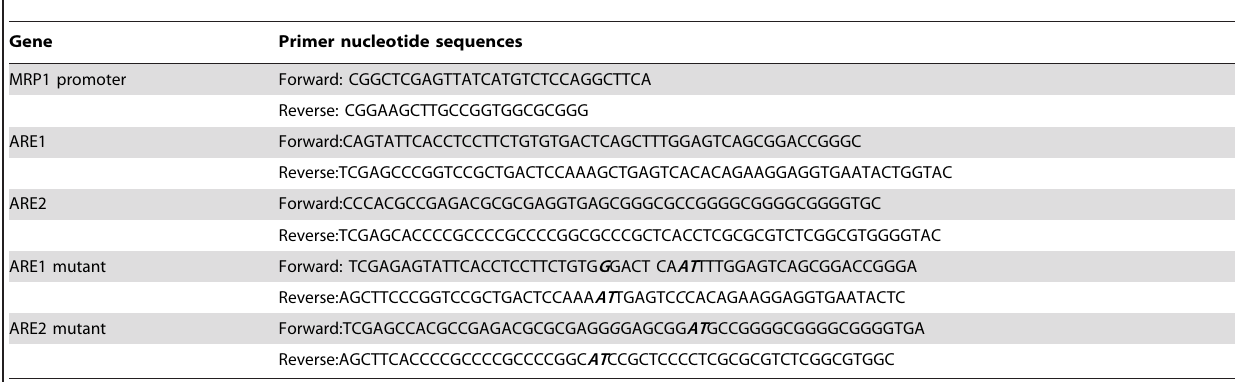
Table 1. Primers used for MRP1 promoter, ARE1,ARE2 and their mutants.